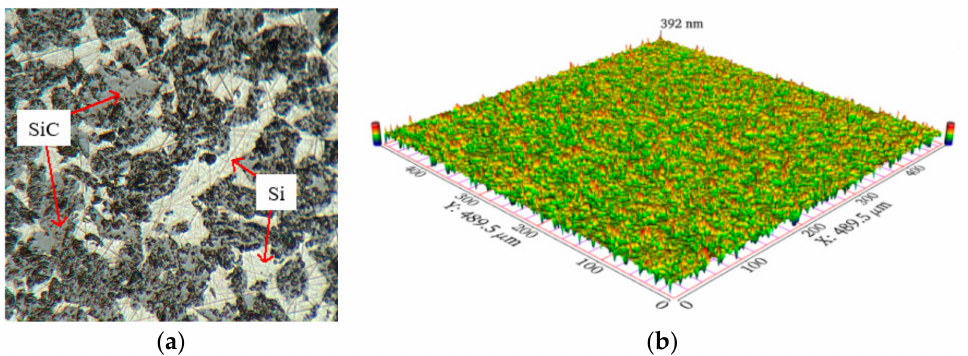
Figure 4. Surface morphology of the original sample. ( a ) 2D view; ( b ) 3D